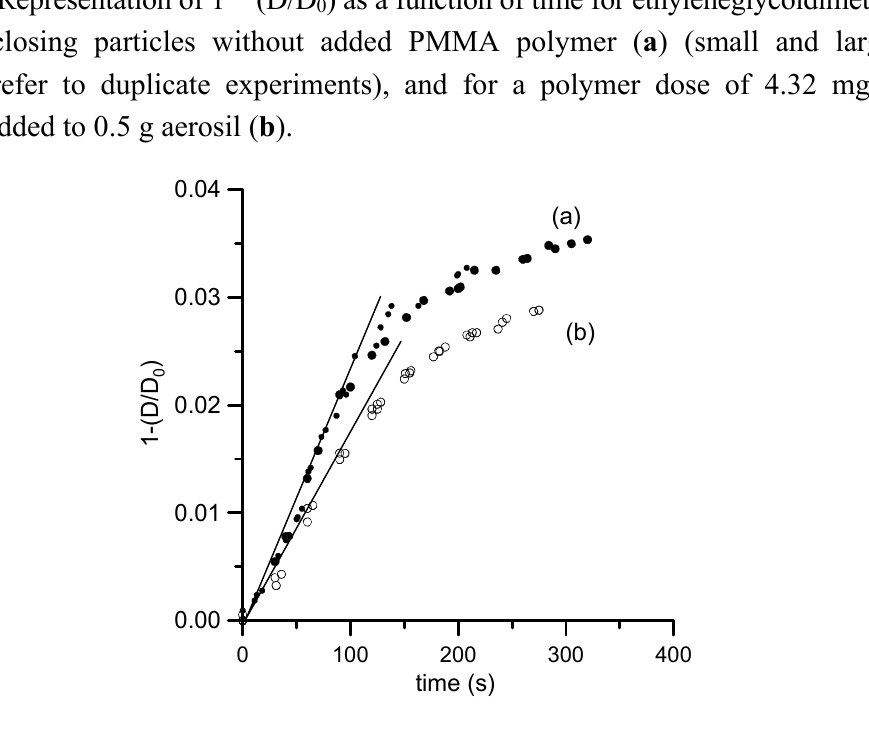
Figure 4. Representation of the rate of shrinkage of composite resins reinforced with aerosil coated at different degrees as a function of the amount of PMMA supplied to the systems.